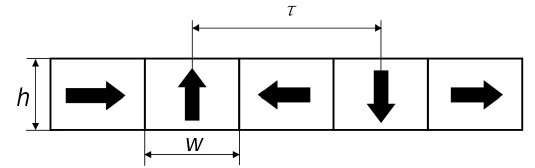
Figure 11. Schematic diagram of pole size.